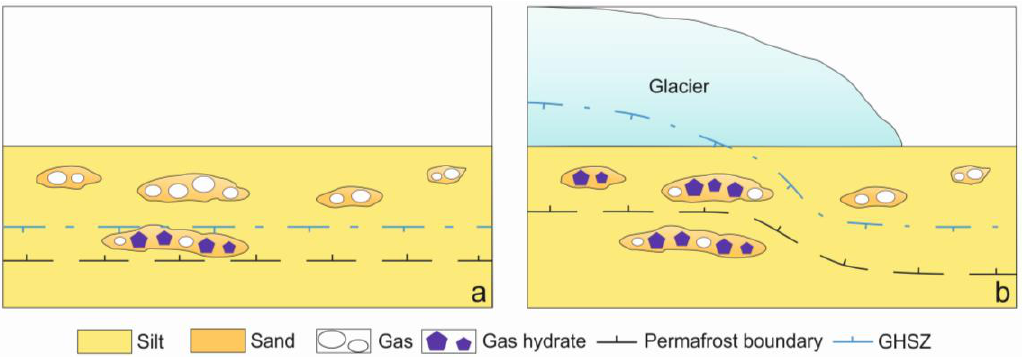
Figure 13. Pore hydrate formation in gas-saturated permafrost under ice load: ( a ) prior to glaciation; and ( b ) after to glaciation.